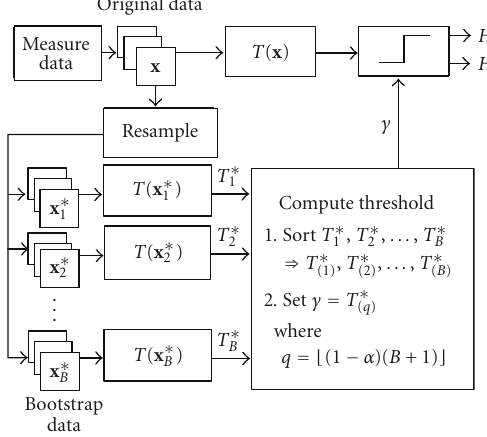
Figure 1: General bootstrap detection procedure for a nominal P e = α and B bootstrap